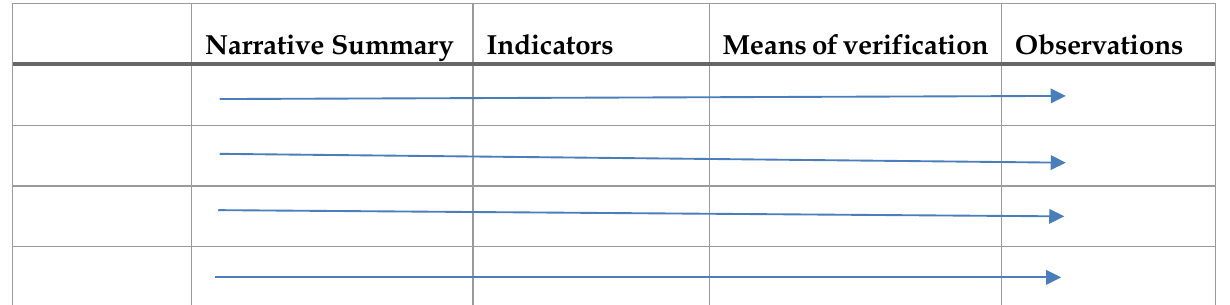
Table 1 : Vertical Logic